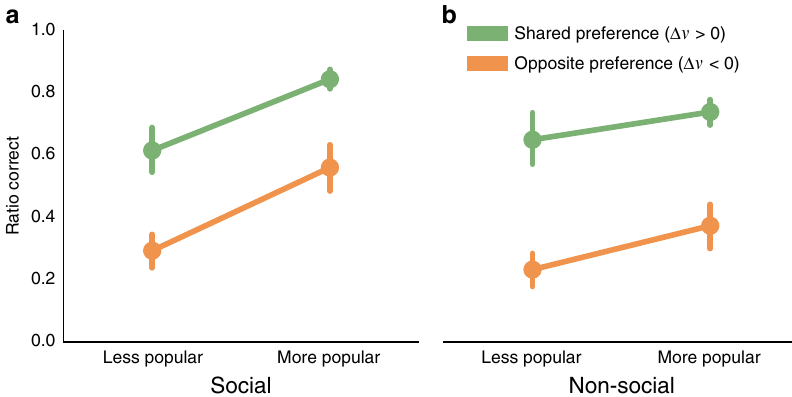
Fig. 3 Performance on fi rst trials for each item pair, separated by preference congruence and item popularity. a In the social experiment ( n = 31), participants performed signi fi cantly better on fi rst trials when they shared their partner ’ s preference ( green , n = 361 observations) than when they did not ( orange , n = 222 observations). They also performed better when the correct answer was relatively more popular ( n = 372 observations) than when it was relatively less popular ( n = 223 observations). b The fi rst-trial performance of participants in the non-social experiment, while better for shared ( green , n = 317 observations) than for unshared preferences ( orange , n = 249 observations), was less sensitive to the item ’ s popularity (more popular, n = 365 observations; less popular, n = 211 observations; see main text for statistical tests.) ‘ More popular ’ items are those preferred by more than 50% of participants in both experiments; ‘ less popular ’ items were preferred by fewer than 50%. Error bars represent bootstrapped standard errors (ranging between 0.03 and 0.08) clustered by participant